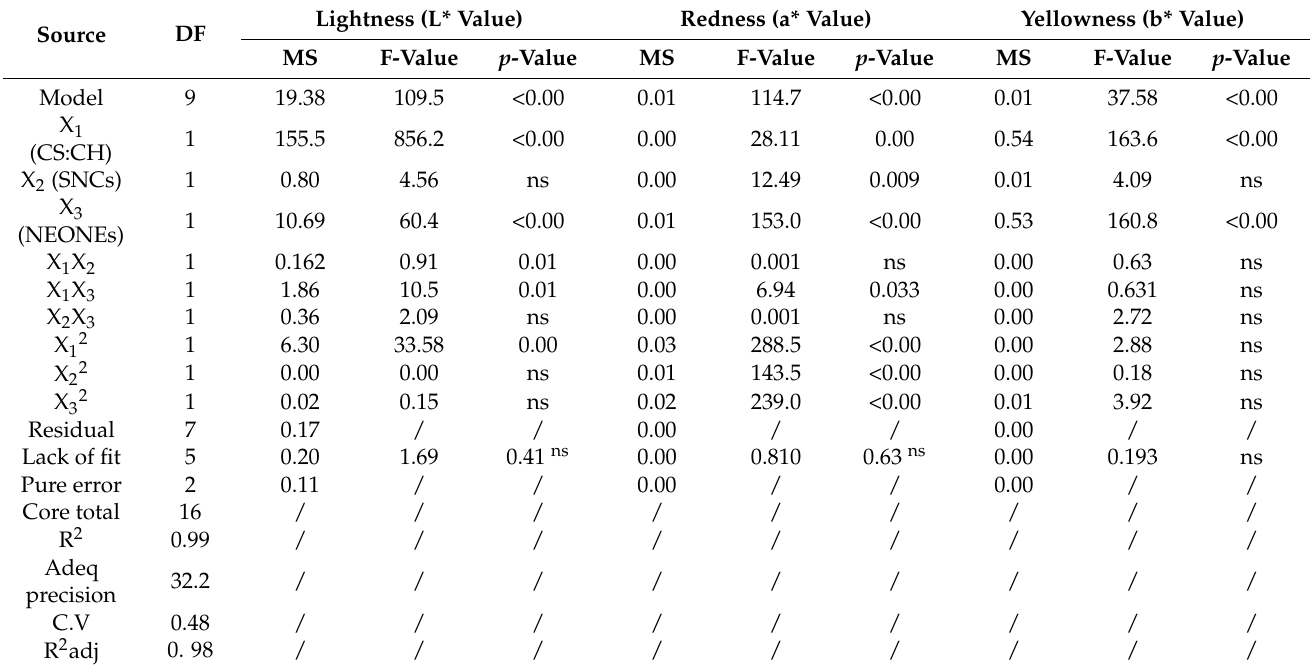
Table 4. ANOVA table for the second-order polynomial models constructed for each the color response